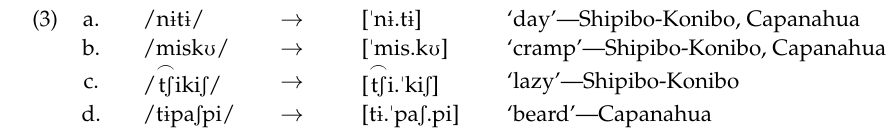
Languages 2021 , 6 , x FOR PEER REVIEW